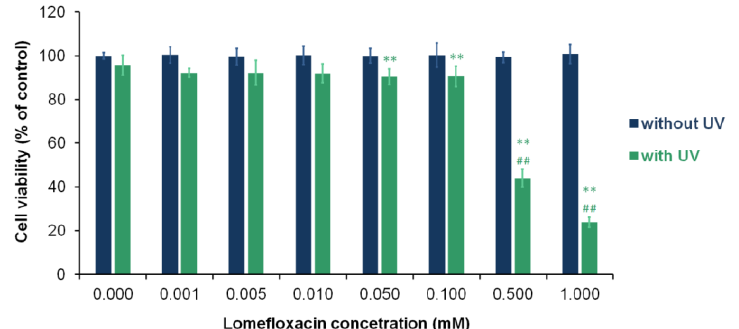
Figure 1. Lomefloxacin decreases the viability of fibroblasts under UVA radiation. Cells were exposed to increasing concentrations of lomefloxacin and UVA radiation at a dose of 1.3 J/cm 2 . The viability of cells was examined by the WST-1 assay. Data are expressed as a percentage of the controls. ** p <0.01 vs. control; ## p < 0.01 vs. non-treated cells exposed to UVA radiation.